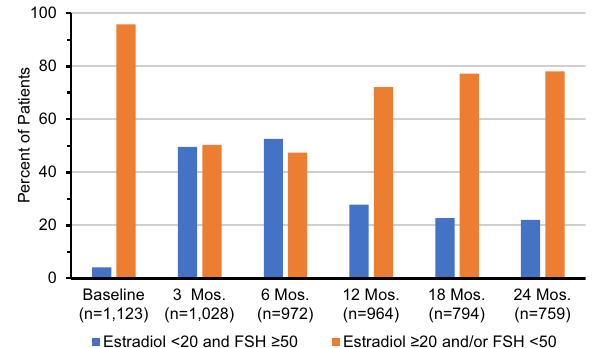
Fig. 2 Distribution of Combined Estradiol and FSH levels over